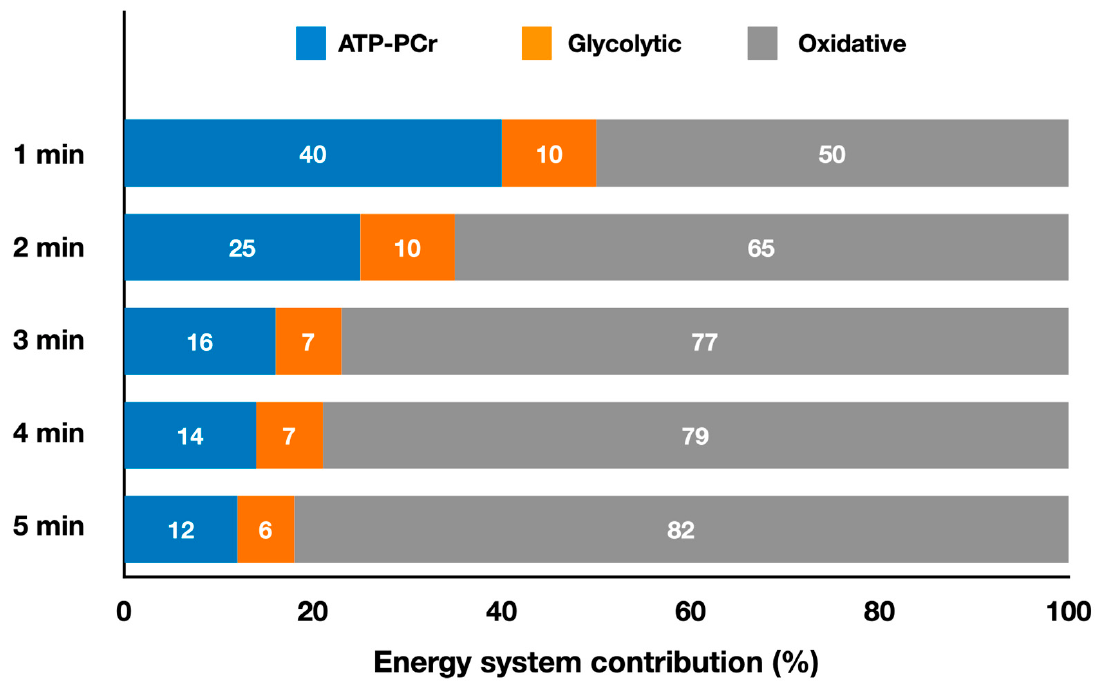
Figure 4. Contributions of the oxidative, ATP-PCr, and glycolytic systems during judo simulated matches lasting from 1 min up to 5 min (adapted from Julio et al. [16]). The values represent the mean percentage of each energy system for each duration (refer to the text for specific comparisons between different match durations).